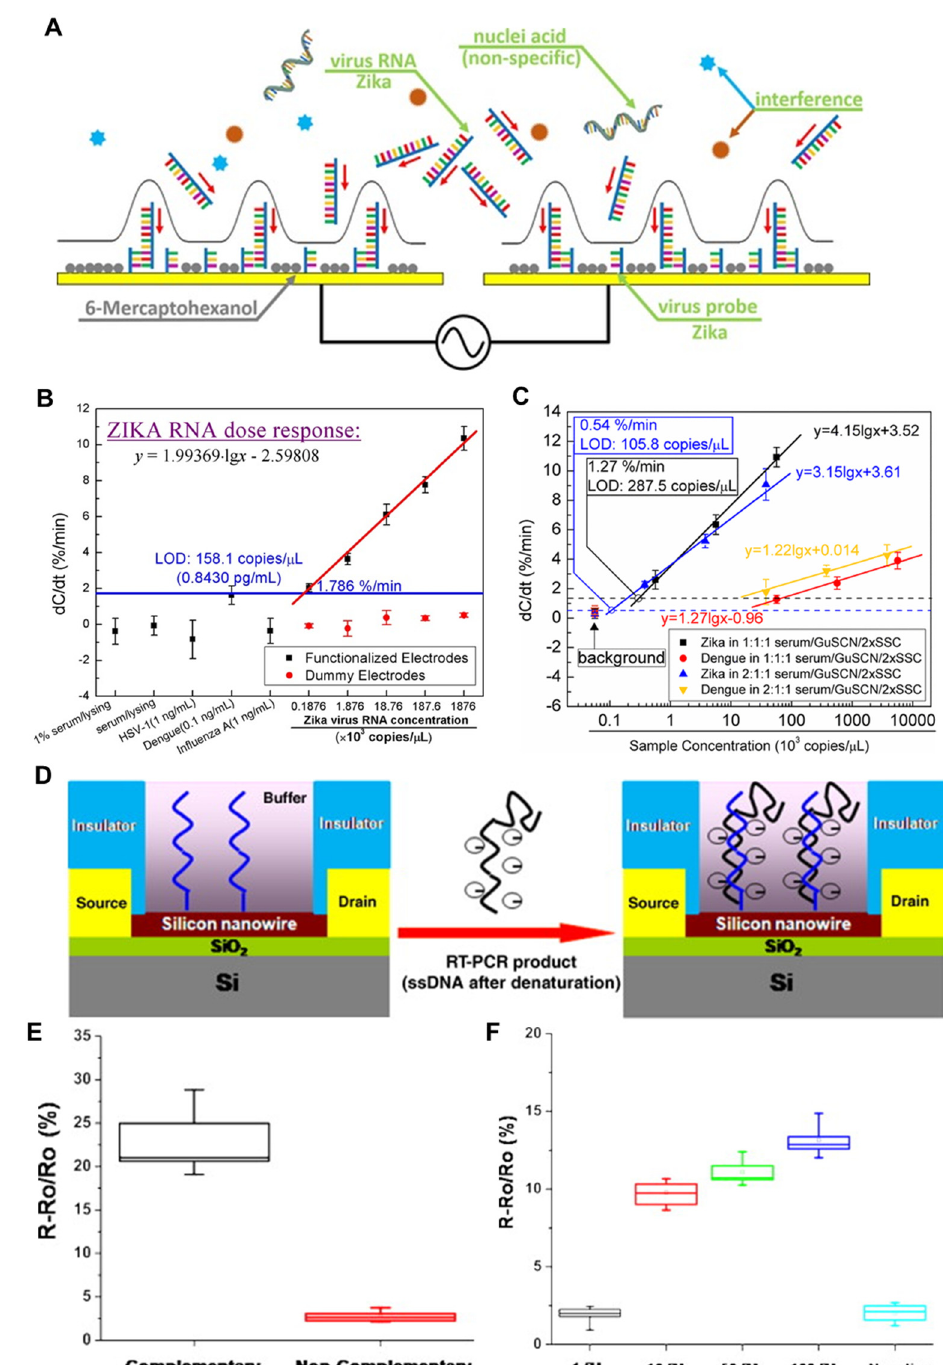
Figure 5. DNA − technology − based ZIKV and the DENV detection method using electrical method. ( A ) Conceptual drawing of ZIKV RNA affinity sensor with AC electrokinetics (ACEK) capacitive sensing. Analytes are attracted towards the electrode surface through ACEK effects. Specific binding between the functionalized ZIKV probe and ZIKV RNA causes a change at the interface (Cint), and the binding leads to a change in Cint, which is detected electrically using the same ACEK signal. Other particles, including influenza A virus, human herpesvirus virus 1 (HSV − 1), DNA and DENV RNA, are considered non-specific interferences. ( B ) Responses of non-specific nucleic acid (HSV − 1 and DENV) and virus (influenza A), and dose–response of ZIKV RNA spiked in serum/lysing solution. Reproduced with permission from [97], published by European Chemical Societies Publishing, 2017. ( C ) Dose responses of ZIKV gRNA human serum samples in 1:1:1 and 2:1:1 mixtures of serum, Guanidine thiocyanate (GuSCN), and 2 × saline-sodium citrate (SSC) as hybridization buffers. ZIKV